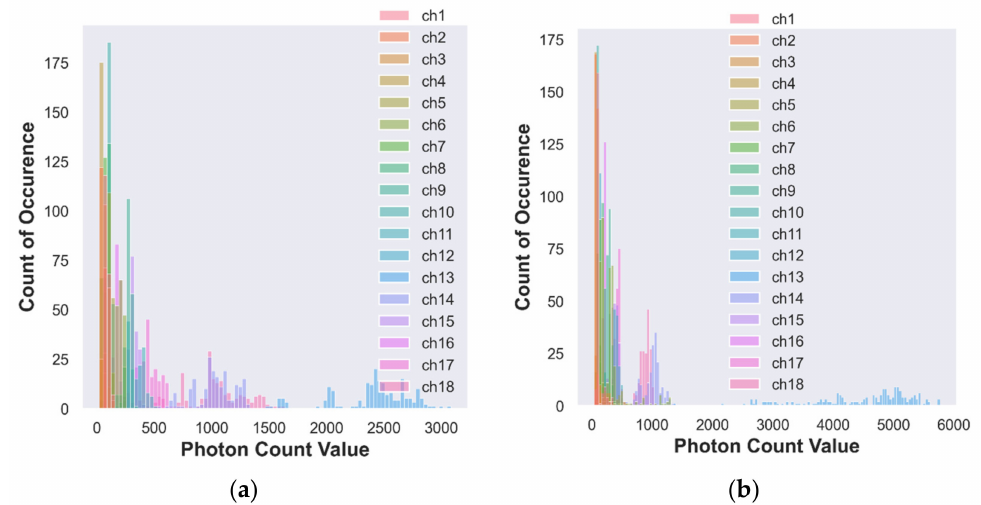
Figure 4. ( a ) Histogram of photon count for conventional tomato; ( b ) histogram of photon count for organic